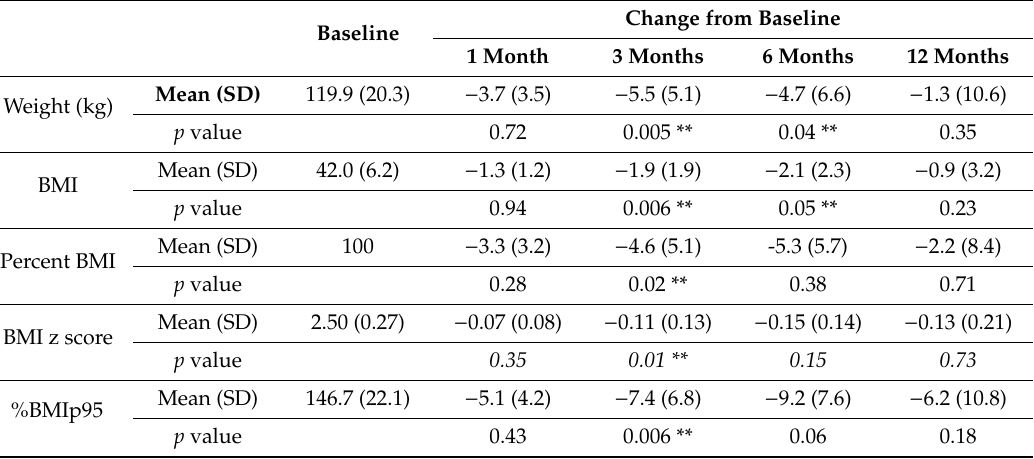
**: repeated measures analysis of variance, p < 0.05.